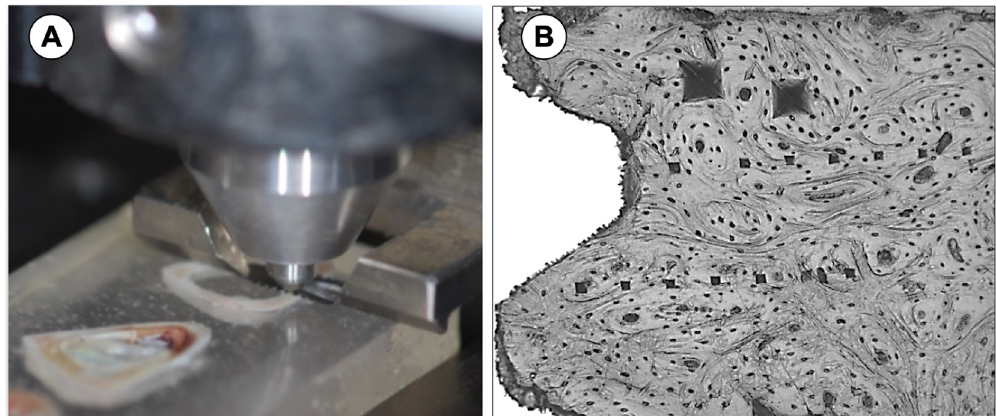
Figure 2- Dynamic Indentation test. A - Indentation moment in metallic device with the tibia embedded in polyester resin. B - Two indentations in a cortical bone close to the implant